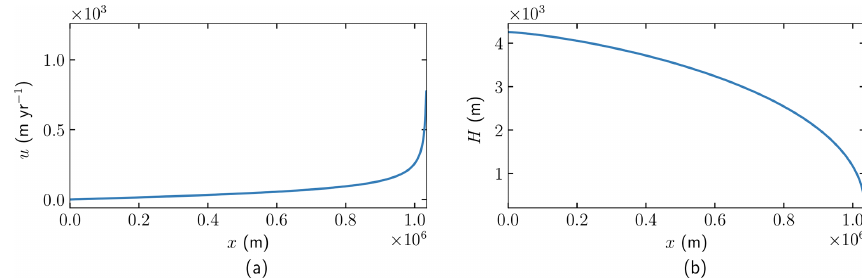
Figure 2. The analytical solutions u(x) and H(x) in (13) for a grounded ice in [ 0 ,x GL ] .